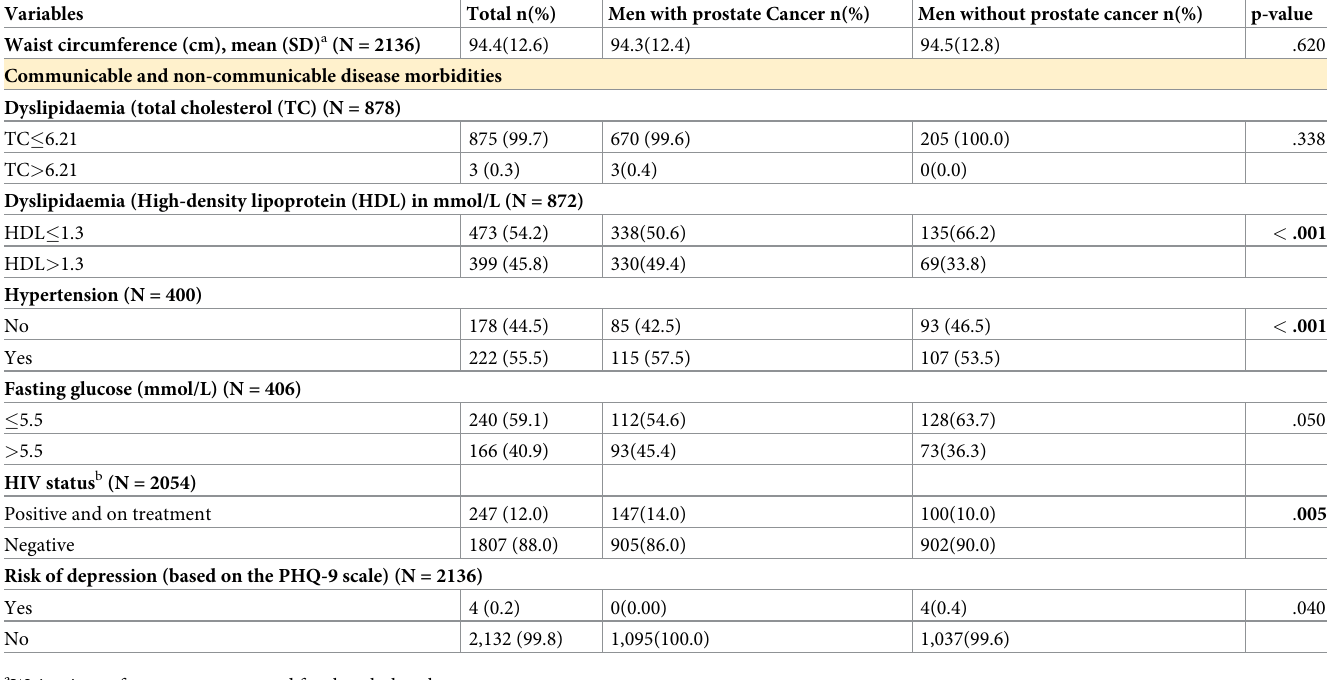
Table 2. Measured multimorbidity profile in men with and without prostate